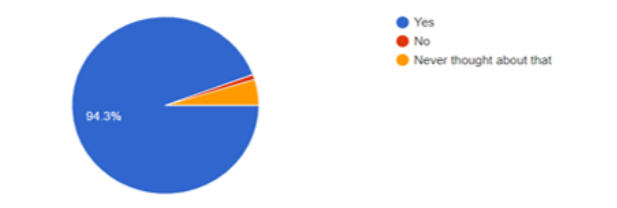
Figure 6: Reviewof green recreational areas as important part of everyday lives